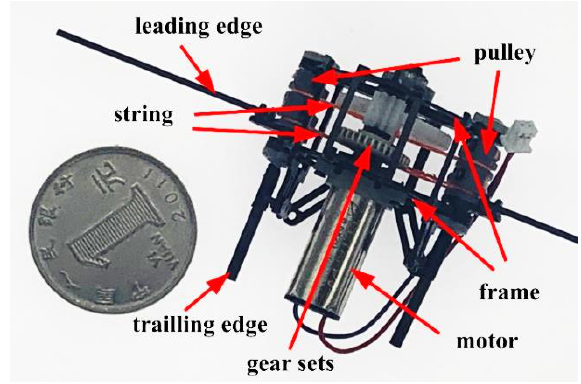
Figure 5. The physical drawing of the flapping wing mechanism.